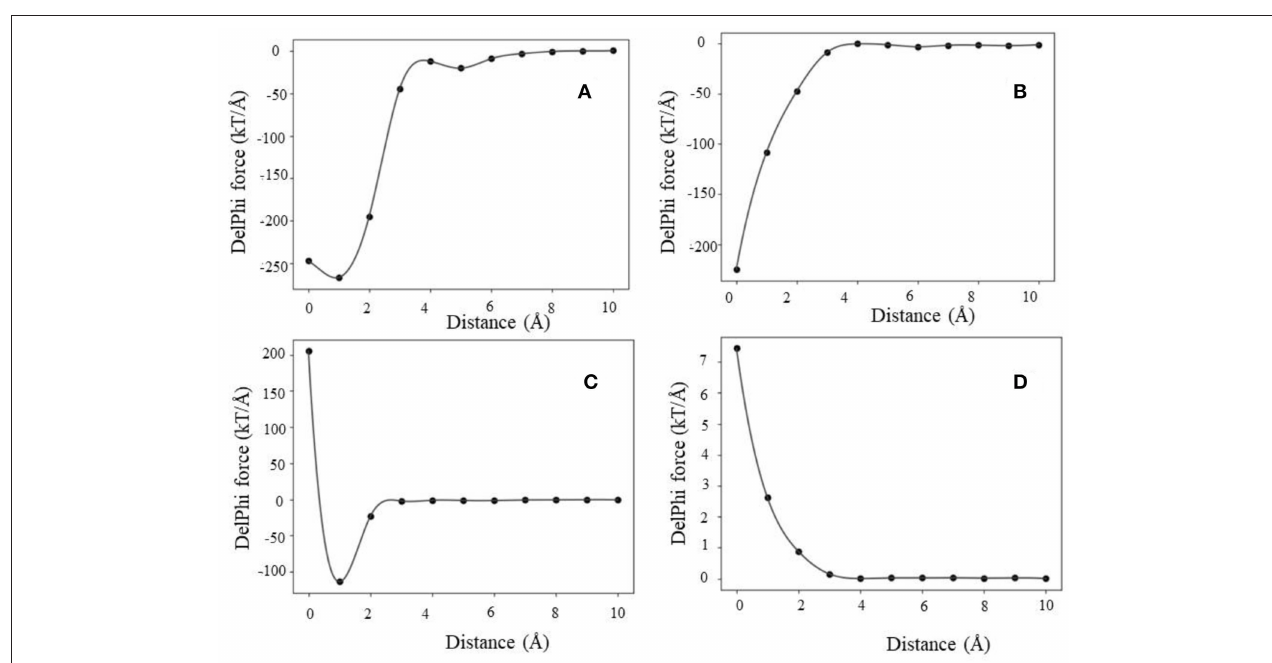
FIGURE 3 | Representative examples of F int profiles obtained using the 2-dielectric model: (A) maximum attraction force at a particular distance, (B) maximum attraction force at bound state, (C) soft landing, and (D) repulsive force.